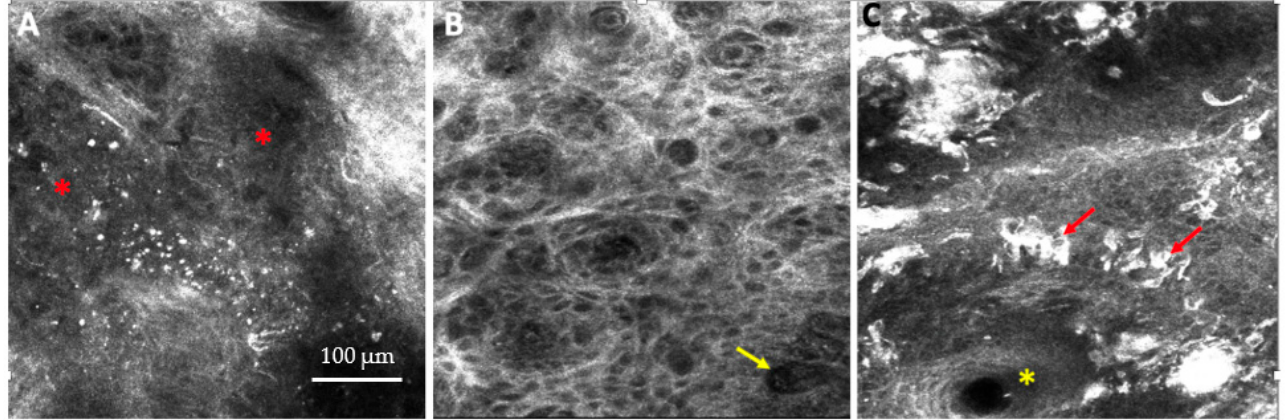
Figure 1. ( A – C ) Reflectance confocal microscopy (RCM) images of ( A ) basal cell carcinoma (BCC) showing tumor nodules (red asterisk), ( B ) squamous cell carcinoma showing an atypical honeycomb pattern at the spinosum layer with prominent vessels (yellow arrow), and ( C ) melanoma showing clusters of atypical melanocytes (red arrows) in the epidermis and around a hair follicle (yellow asterisk). Field of view: ( A – C ) = 500 × 500 µm. Image A courtesy of Ms. Rozina Zeidan, Clinical Research Specialist, Memorial Sloan Kettering Cancer